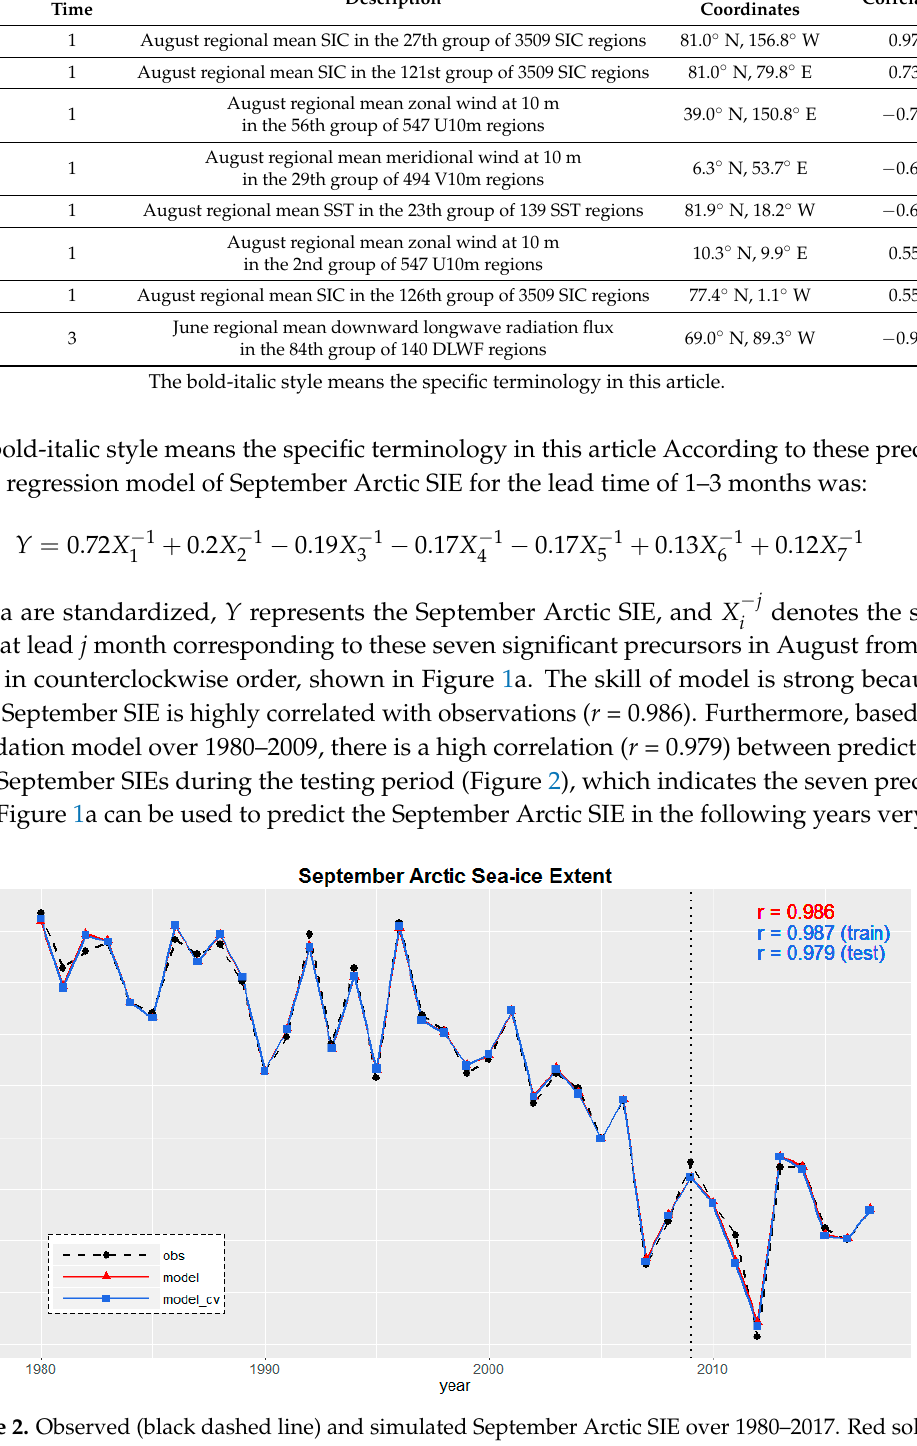
Figure 2. Observed (black dashed line) and simulated September Arctic SIE over 1980–2017. Red solid line represents the linear regression model of September SIE using the whole data, while the blue one represents the crossed-validation model of September SIE using 1980 − 2009 training data. The blue one almost overlaps with the red one totally. The left of vertical dotted line means the fitted training results (1980 − 2009) based on the crossed-validation model, while the right of vertical dotted line means the predicted results during the testing period (2010 − 2017).